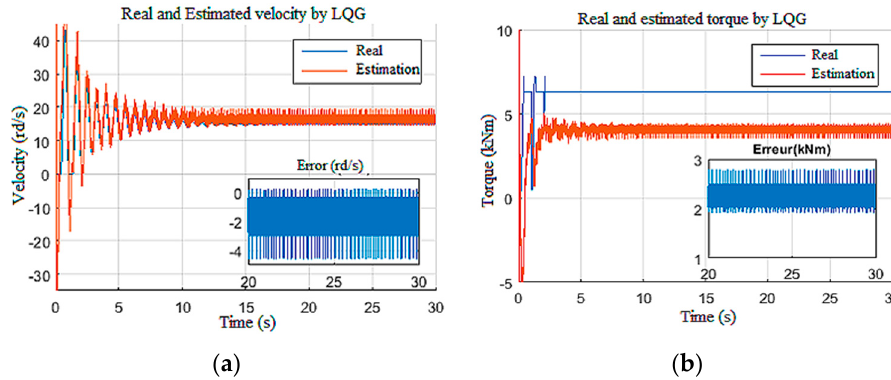
Figure 18. Responses for Scenario 3: ( a ) drill bit velocity; ( b ) torque on bit.